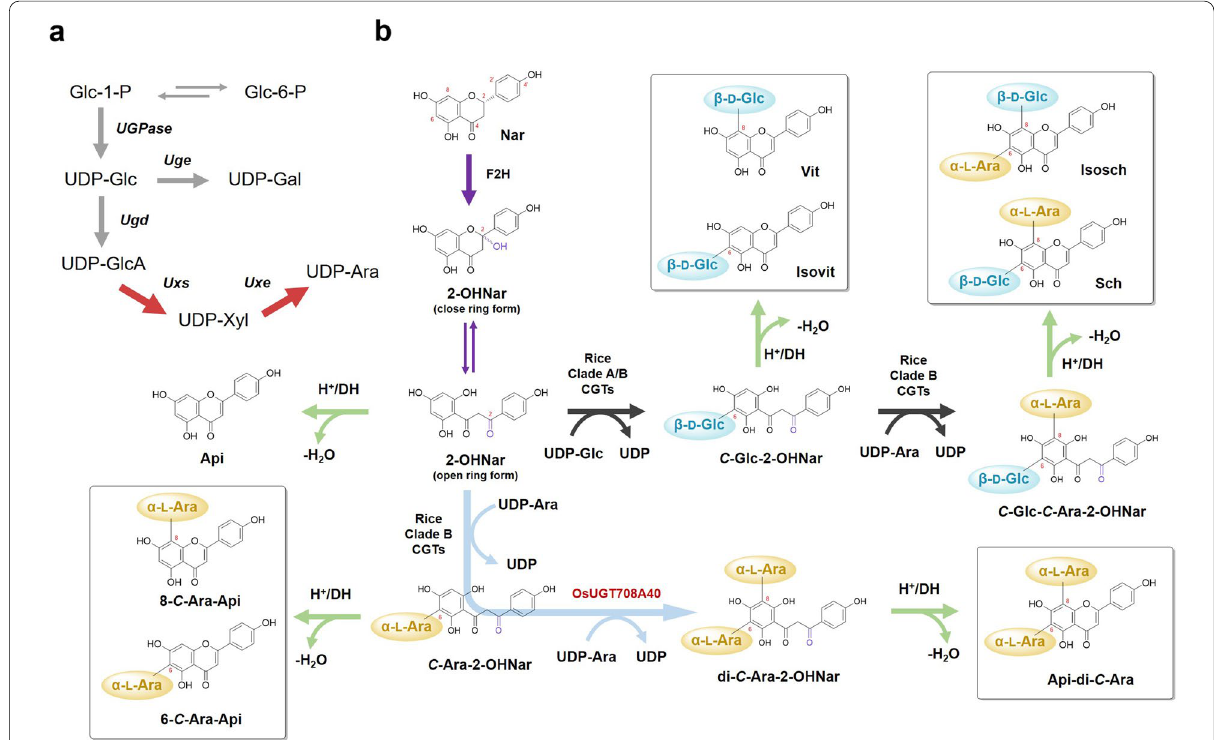
Fig. 2 A proposed biosynthetic network of C -glycosylated apigenin in rice. a UDP-arabinose (Ara) is generated from glucose-1-phosphate (Glc-1-P) via UDP-glucose (Glc) and UDP-xylose (Xyl). Grey arrows represent the native metabolism in E. coli , while the bold red arrows represent an introduced heterologous UDP-Ara pathway. Glc-6-P glucose-6-phosphate, Gal galactose, GlcA glucuronate, UGPase UDP-glucose pyrophosphorylase, Uge UDP-glucose 4-epimerase, Ugd UDP-glucose 6-dehydrogenase, Uxs UDP-xylose synthase/UDP-glucuronic acid decarboxylase, Uxe UDP-xylose 4-epimerase. b A proposed C -glycosylated apigenin pathway starting from naringenin (Nar). Purple arrows represent 2-hydroxylation by flavanone 2-hydroxylases (F2H) and equilibrium of ring-open/closed 2-hydroxynaringenin (2-OHNar). Black